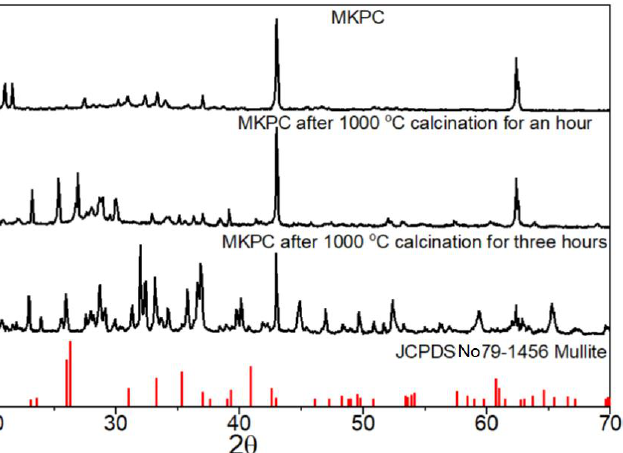
Figure 7. XRD diffractions of the MKPCs before and after the calcination at 1000 °C for one and three hours, respectively.